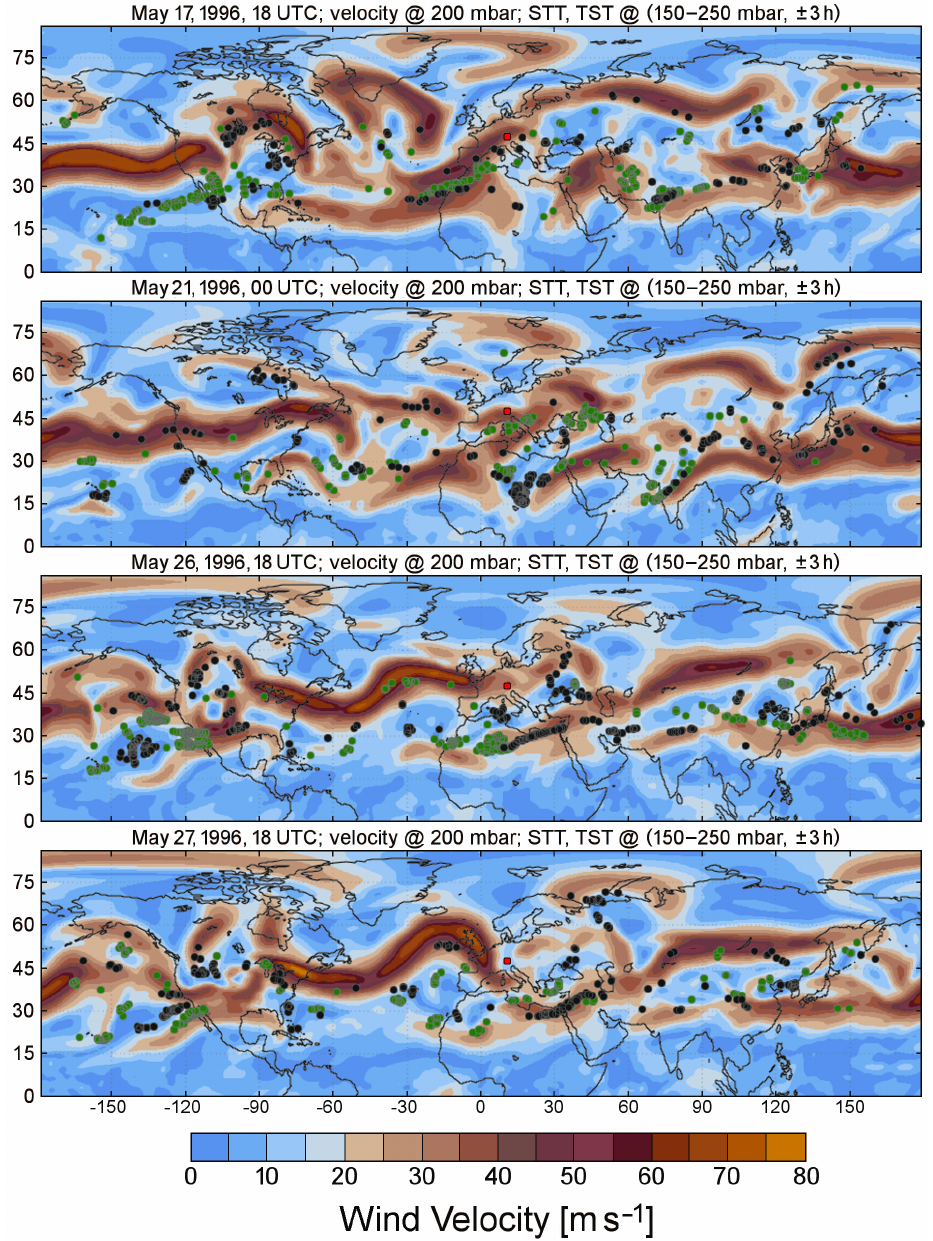
Fig. 7. Selected examples of the ECMWF/LAGRANTO visualizations of the jet streams for Case 1; the position of Garmisch-Partenkirchen is marked with a red dot next to the centre of each panel. The wind speed is colour coded. The positions where trajectories revealed STT or TST between 150 and 200mbar are marked by green and black dots,